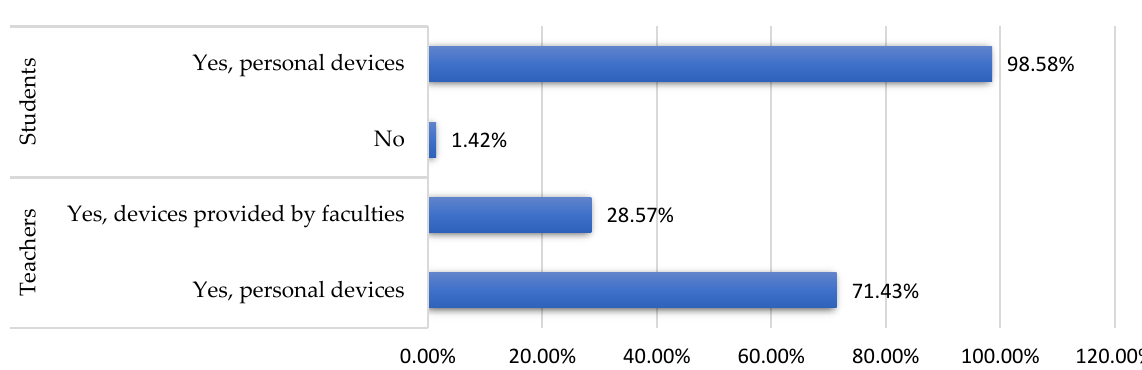
9 of 22 Table 4. Chi-Square results for the associations between participation in courses or trainings related to the use of online platforms and the teachers’ and students’ level of English . Teachers